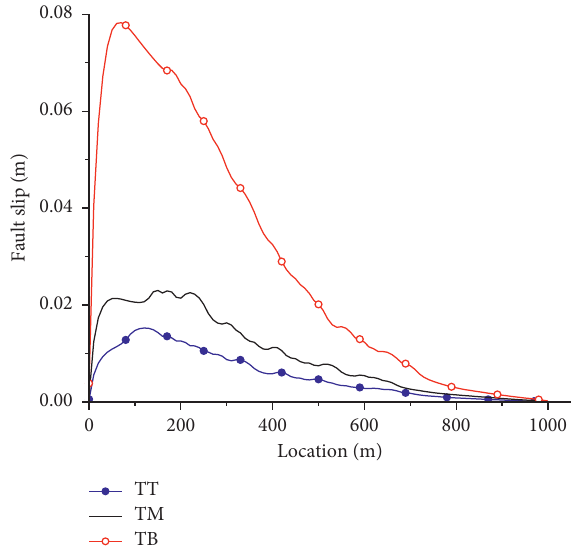
Figure 6: Fault slip along the fault plane when the fracturing region was TT, or TM, or